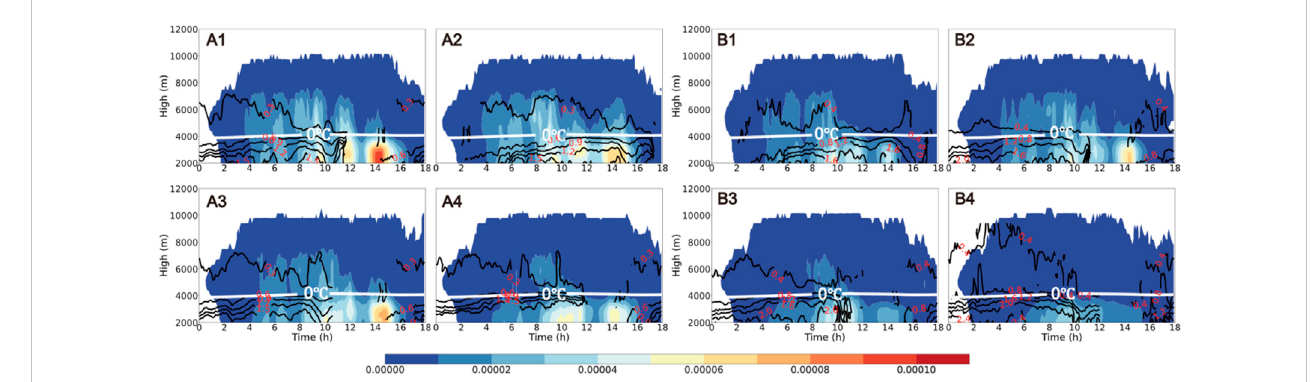
Time variation of the height distribution of rain particle mixing ratio (Unit: g kg − 1 ) with the contour of the mass-weighted average diameter (Unit: mm), and the solid white line is the height of 0 ° C (A) TH-AU. (B) MY-AU; (1) NCCN50 (2) NCC N200 (3) NCCN 2000 (4)